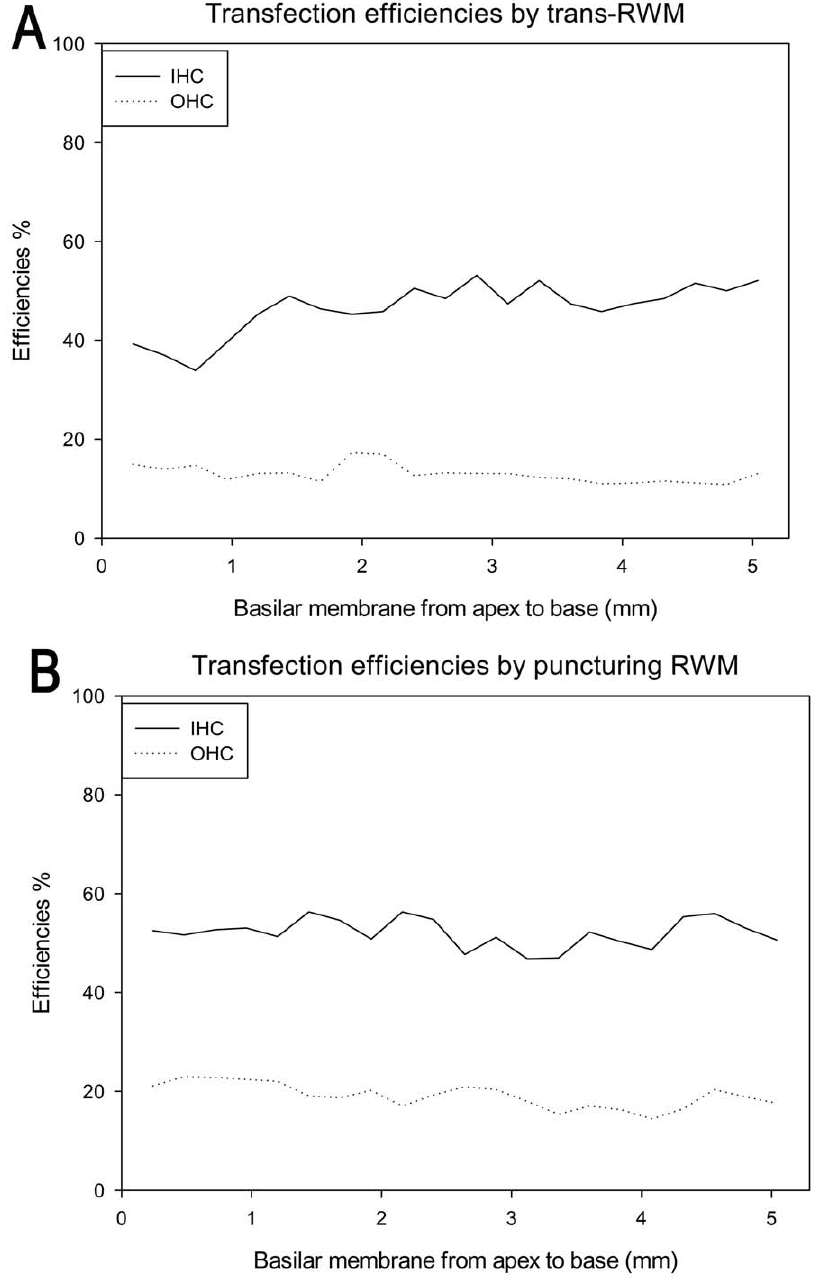
Figure 4. Cochleograms showing transfection efficiency in the OHCs and IHCs A: trans-RWM group, B: RWM-puncture group. IHCs: inner hair cells; OHCs: outer hair cells; RWM: round window